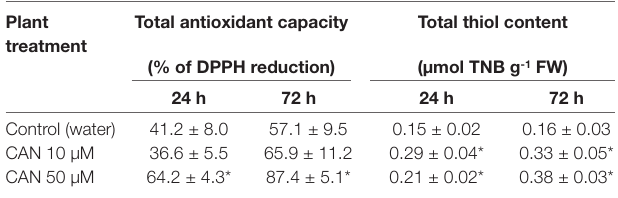
TABLE 2 | Total antioxidant capacity and concentration of total thiols in extracts from roots of the control plants growing in water or from roots of tomato seedlings treated with CAN (10 or 50 µM) for 24 and 72 h.